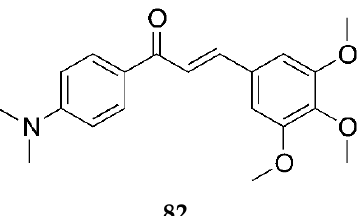
Figure 42. Chemical structure of the N,N -dimethyl 4-aminochalcone derivative with methoxy substitution on ring B.